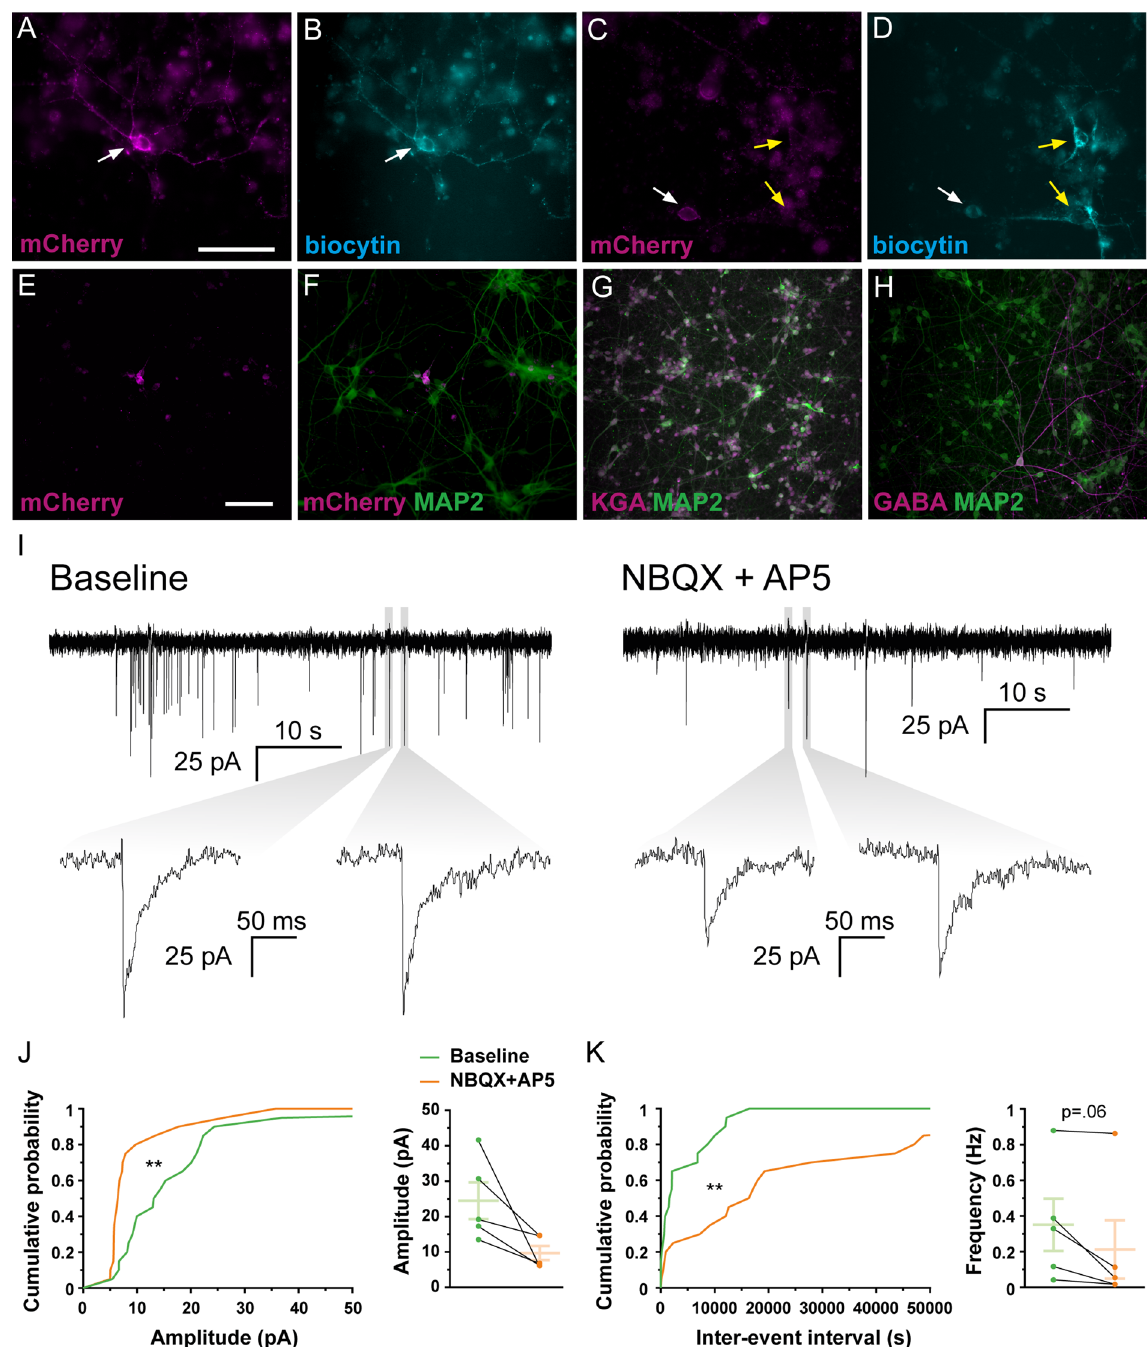
Figure 5. Co-cultures of human primary neurons and hdINs at 35 DIV demonstrate afferent synaptic connections from the primary neurons to the hdINs. Immunohistochemistry of co-cultures of hdINs and human primary neurons used for electrophysiological analysis at 35 DIV. Some of the recorded neurons (biocytin +, B and D ) were also hdINs mCherry + (white arrows, A and C ), and some were mCherry-, indicating that the latter were primary neurons (yellow arrows, C – D ). ( E , F ) The ratio of mCherry + /MAP2 + cells to human primary neurons mCherry-/MAP2 +. ( G , H ) Human primary neurons were mostly glutamatergic (KGA +, G ) and very few GABAergic (GABA +, H ). ( I ) Spontaneous synaptic currents in whole-cell voltage- clamp mode showing afferent connections to the hdINs at 35 DIV. Some of the events disappeared when NBQX and AP5 where applied (right). ( J , K ) Cumulative probability curves comparing the events during baseline (green) and addition of the drugs (orange) for both amplitude ( J , left) and inter-event interval ( K , left). Distribution of the mean amplitude ( J , right) and frequency ( K , right) for spontaneous synaptic currents. Scale bar: 100 µm. Mean ± SEM. Kolmogorov–Smirnov test for cumulative distributions and Wilcoxon test for comparison of paired means (n = 5). Kolmogorov–Smirnov test: ** p <